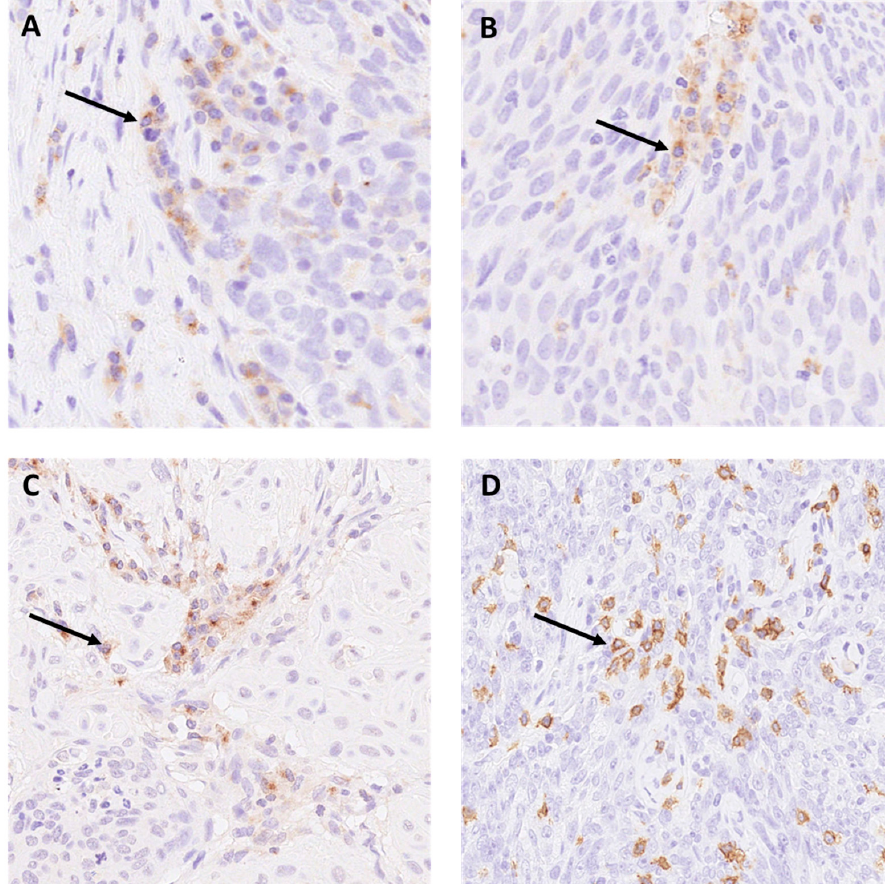
Figure 1. Expression of ( A ) LAG-3 on immune cells (magnification 200×). ( B ) TIM-3 (magnification 200×) ( C ) VISTA (magnification 200×) on immune cells. ( D ) Membrane-pattern of CD8 positive lym- phocytes in oropharyngeal squamous cell carcinoma (OPSCC) (magnification 200×). Arrows point- ing to positive staining. LAG-3, TIM-3 and VISTA expression on immune cells was associated with an in- flamed tumor microenvironment (CD8+ TILs) in the entire cohort ( p < 0.001, p < 0.001, p = 0.007,) and in HPV-related OPSCC ( p = 0.001, p < 0.001, p < 0.001). In HPV-negative OPSCC patients, only TIM-3 expression was associated with high infiltrate of CD8+ TILs ( p = 0.006) whereas LAG-3 and VISTA expression were not ( p = 0.267, p = 0.695; Table 2).